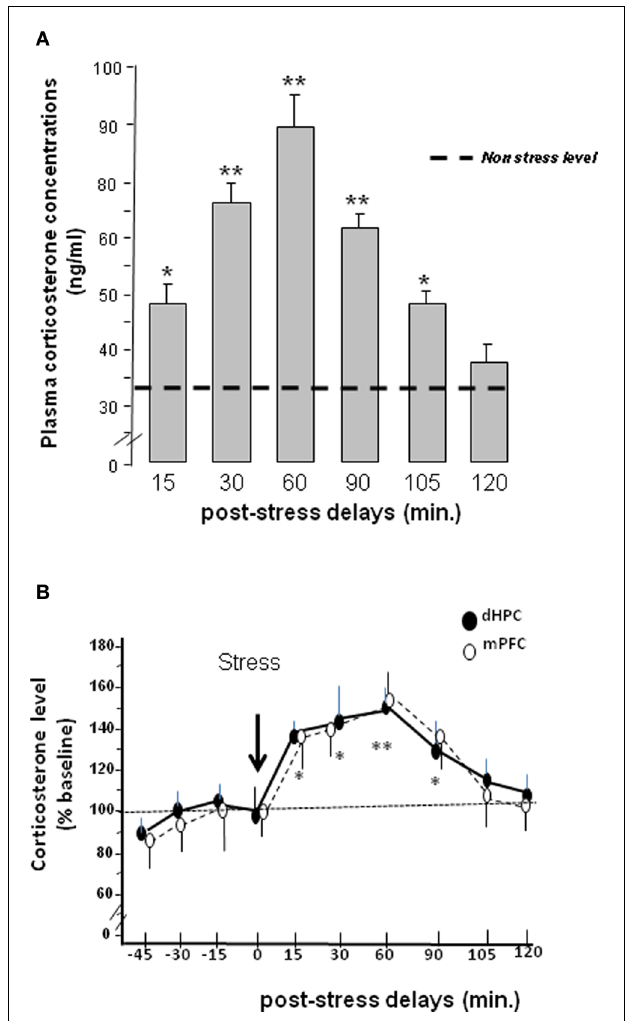
FIGURE 3 | (A) Plasma concentrations (expressed in ng/mL) at different post-tress delays after the occurrence of the acute stress. ( ∗ p < 0 . 05 and ∗∗ p < 0 . 01 vs. non-stress level). (B) Intracerebral double-microdialysis. Time-course evolutions of stress-induced corticosterone rises within the dHPC (dark circles) and mPFC (white circles) measured by microdialysis in the same animal. In dHPC and mPFC, the time-course evolutions of corticosterone are similar. In both brain areas, corticosterone levels significantly differed from baseline from the 15min post-stress delay to the 90min one. The maximum corticosterone concentration level is measured at the 60min post-stress delay followed by a return to baseline 105min after stress delivery. Results are expressed in relative concentrations. No significant difference between groups was observed (NS). Comparisons to baseline for dHPC and mPFC: ∗ p < 0 . 05; ∗∗ p < 0 . 01.